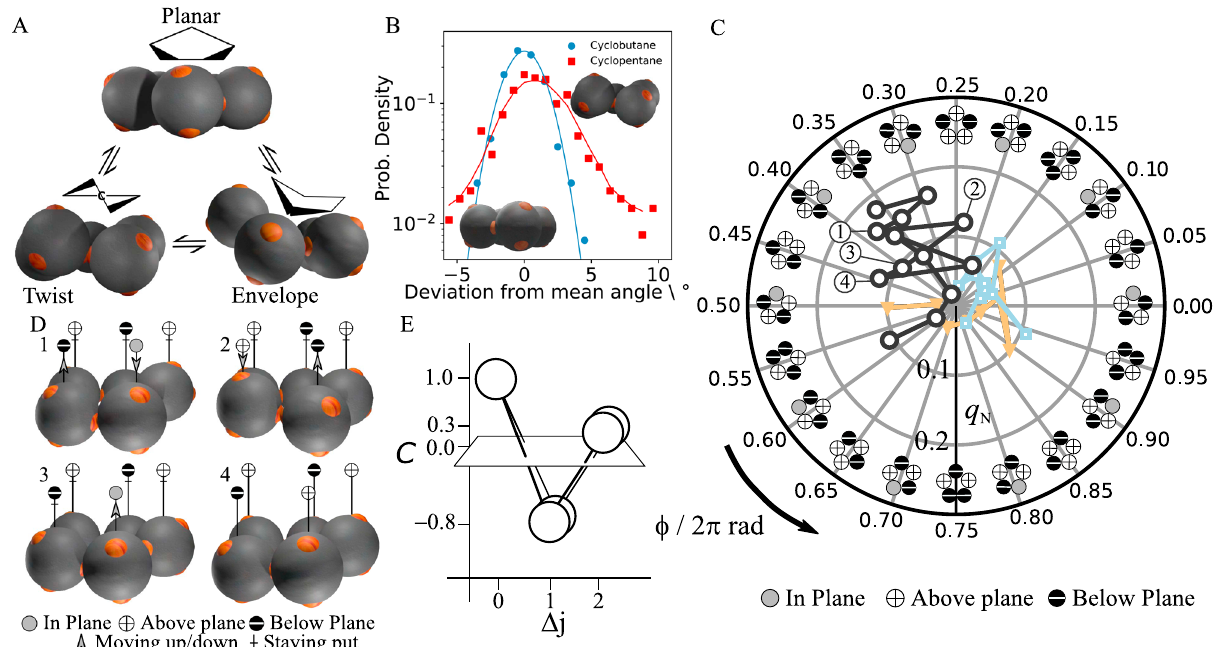
Fig. 2 Conformations and pseudorotation of colloidal cyclopentane. A Three-dimensional reconstructions of typical conformations of colloidal cyclopentane: planar conformation (top), ‘ twist' (or ‘ half-chair') conformation (left), and ‘ envelope' (or ‘ bend') conformation (right). B The distribution of inter-particle angles in cylcobutane (blue circles) and cyclopentane (red squares). The solid lines are a guide to the eye. C Representation of cyclopentane conformations in polar q – ϕ space. At each 0.05 ⋅ 2 π interval, a 2D representation of the ring is shown. The three paths (grey circles, orange triangles, and blue squares) show typical puckering routes of a thermally activated ring through q – ϕ space. The four labelled subsequent points along the grey circle path correspond to the snapshots in D . D Time series of three-dimensional con fi gurations showing pseudorotation of colloidal cyclopentane. Snapshots are Δ t = 12 s apart, while the typical relaxation time of a conformation is 24 s, see Supplementary Note 4. Symbols + and − indicate particles above and below the average plane, respectively, and arrows indicate particle movement towards the next time step. E Correlation function of out-of-plane displacements C ð Δ j Þ ¼ h z (cid:3) z i = h z 2 i in a perspective view, illustrating average puckered con fi guration of the ring. Source data are provided as a Source data fi j j þ Δ j j